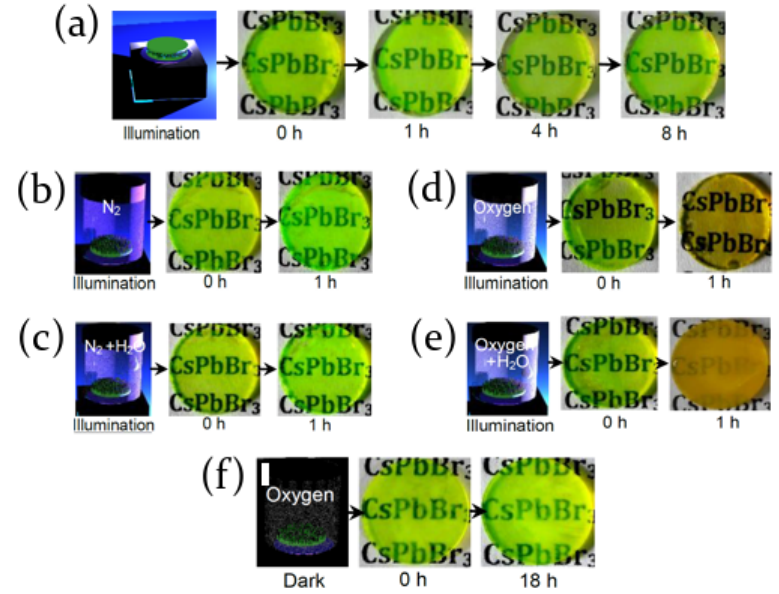
Figure 9. Optical images of the CsPbBr 3 film ( a ) sandwiched between two quartz coverslips as a function of the illumination time (175 mW/cm 2 , RH 60%). Optical images of the CsPbBr 3 film exposed to ( b ) pure N 2 in an illuminated environment, ( c ) N 2 + 0.5 µ L H 2 O in an illuminated environment, ( d ) oxygen in an illuminated environment, ( e ) oxygen + 0.5 µ L H 2 O in an illuminated environment and ( f ) oxygen in a dark environment. Adapted with permission from [62]. Copyright © 2017, American Chemical